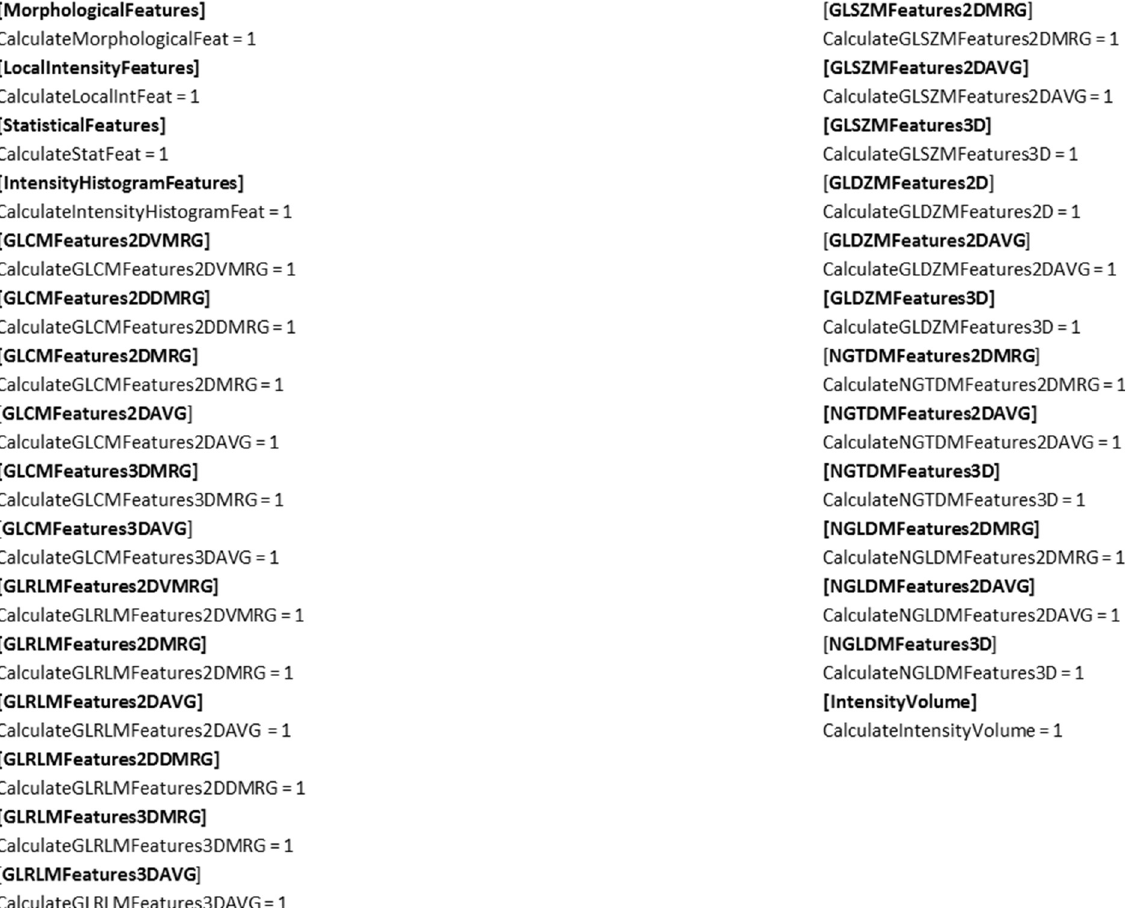
Fig 5. Example of feature output definition file. If a feature group should not be included in the calculations, the value for the corresponding group has to be set to